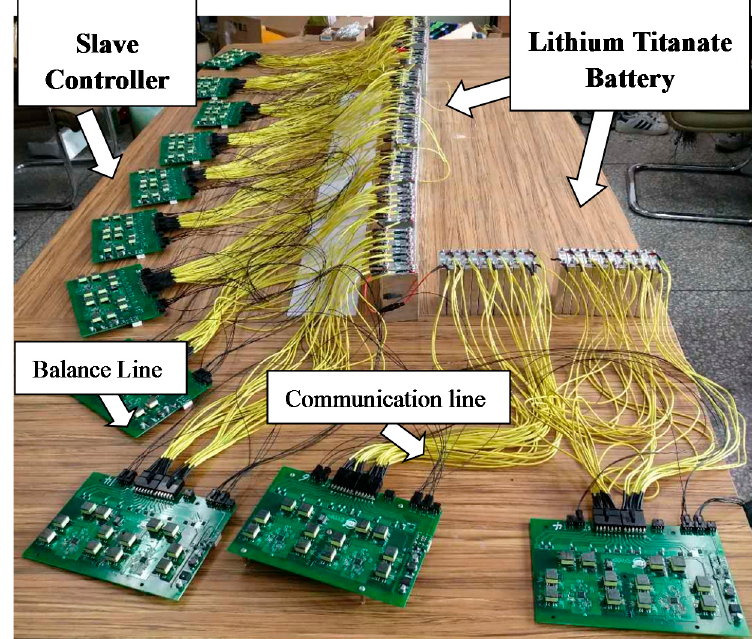
Figure 15. Slave controllers and battery pack.